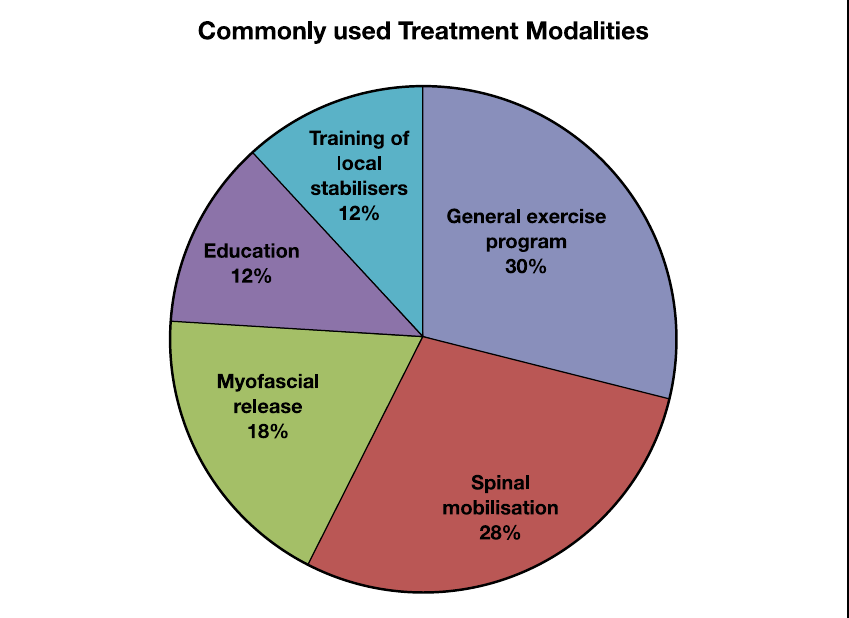
Figure 1: commonly used treatment modalities in the management of clBP (n=141)